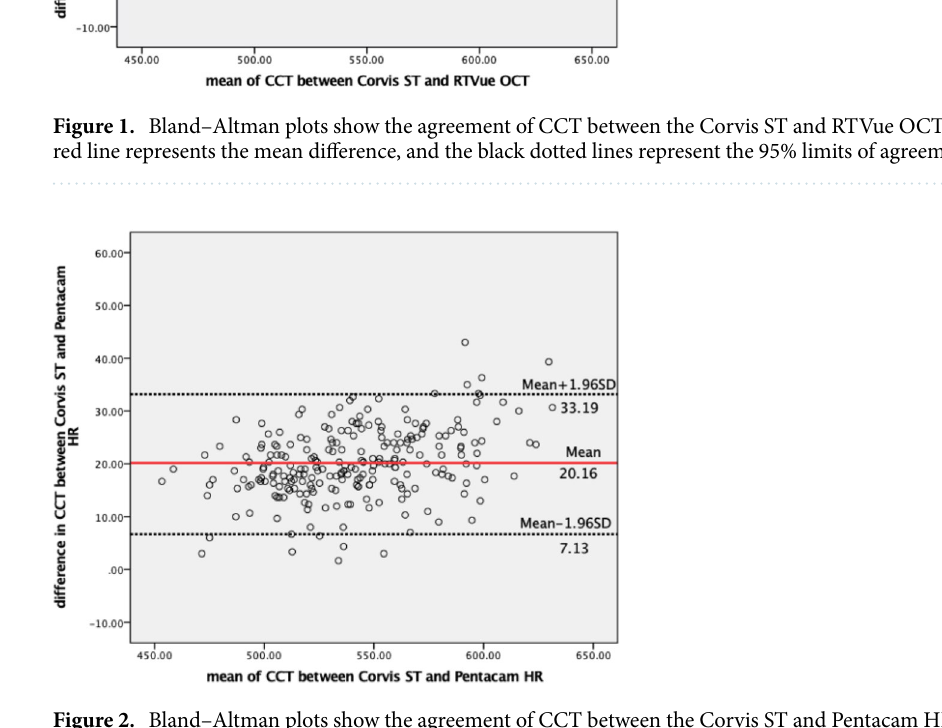
Figure 2. Bland–Altman plots show the agreement of CCT between the Corvis ST and Pentacam HR. The solid red line represents the mean difference, and the black dotted lines represent the 95% limits of